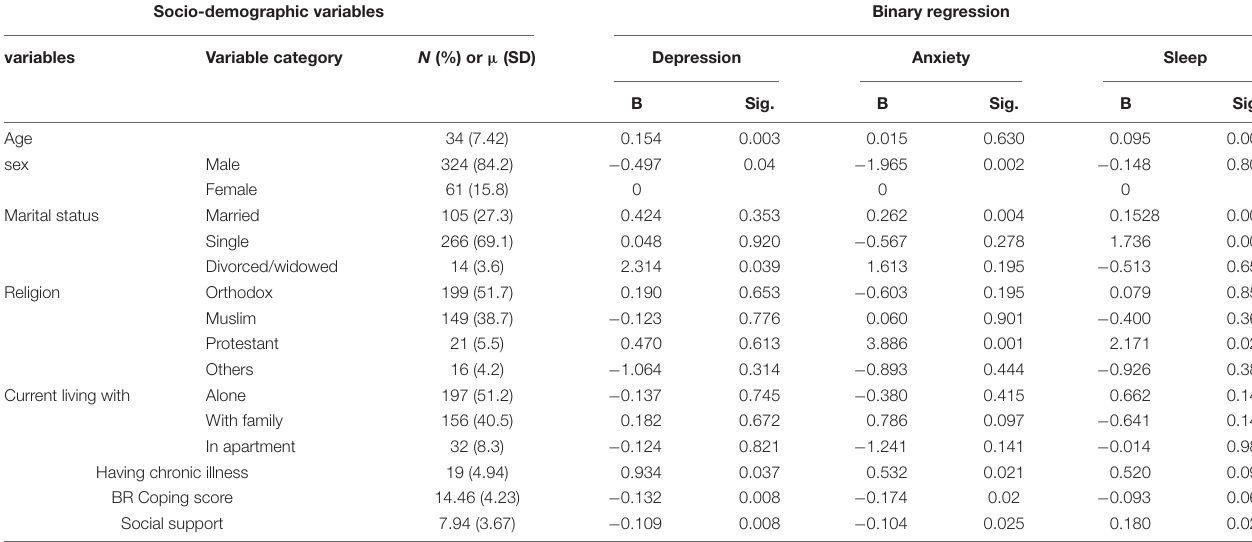
TABLE 1 | Socio-demographic data participants and binary linear regression analysis of depression, anxiety, and sleep problem. Socio-demographic variables Binary regression